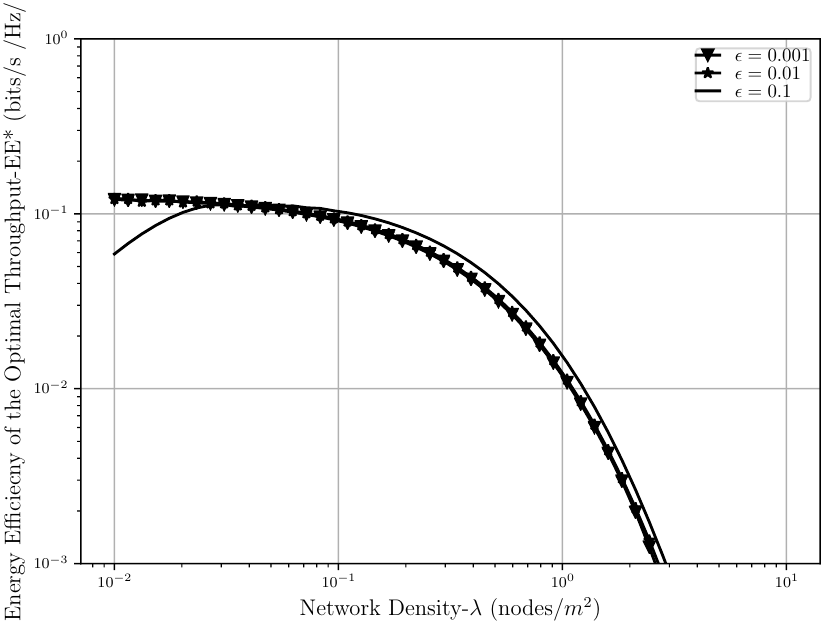
Figure 11. Energy efficiency of the optimal throughput EE ∗ versus the number of retransmissions m with different network densities λ , α = 4 and r 0 =